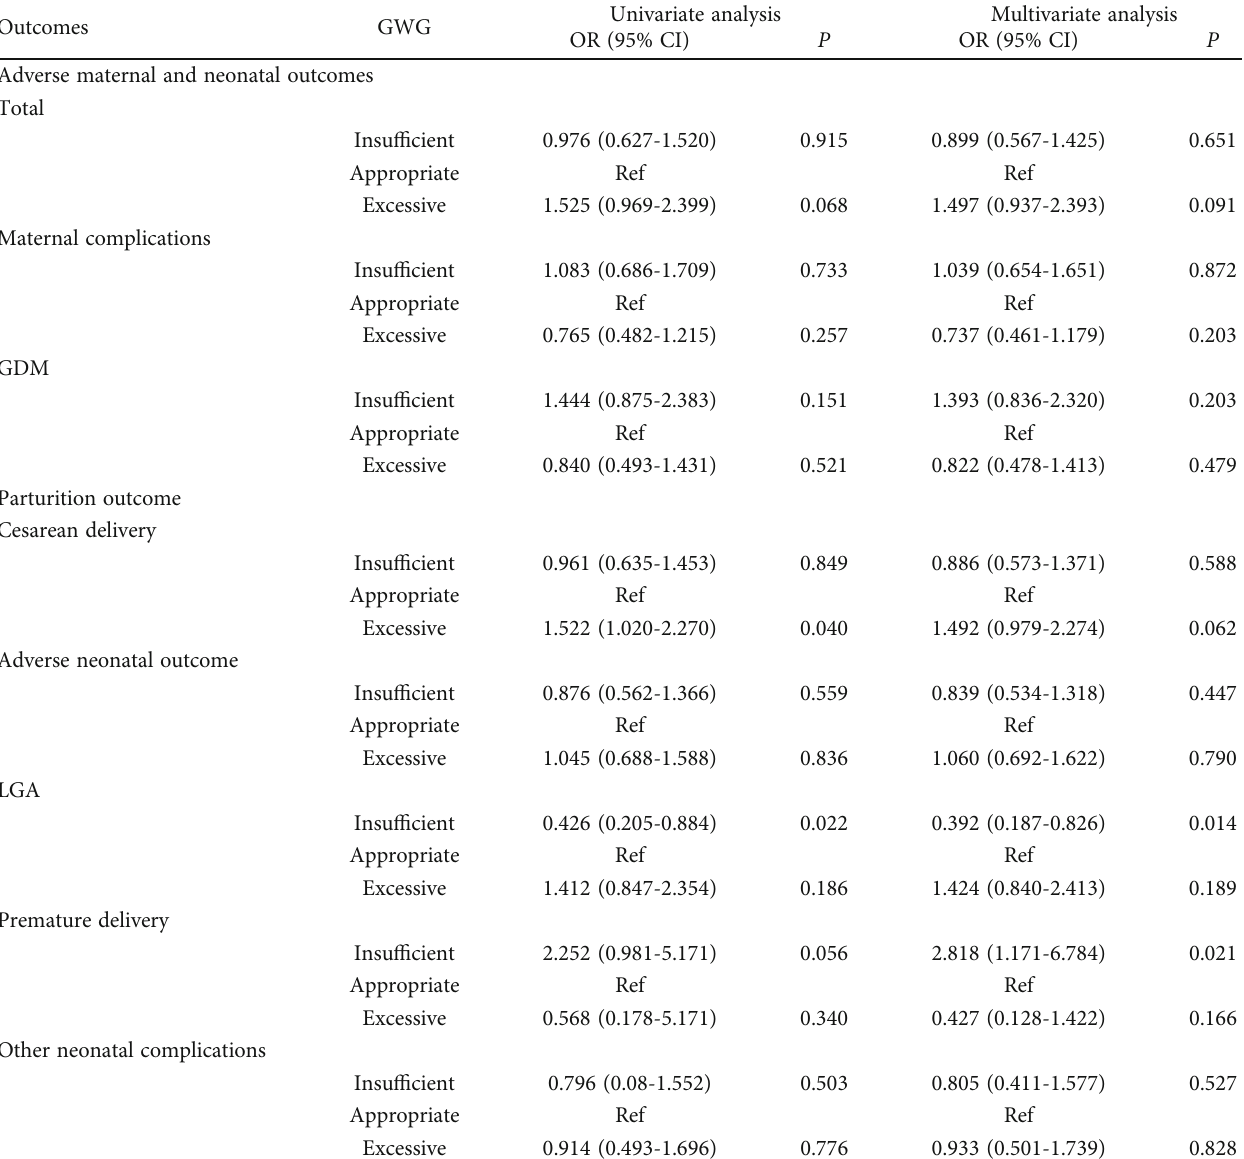
Table 4: E ff ects of GWG on maternal and neonatal adverse